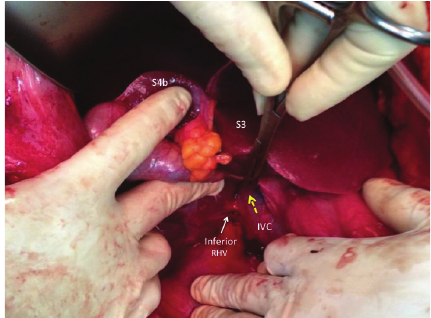
Figure 5: Segments III (S3) and IVb (S4b) of the liver are elevated to allow access to the IVC caudally. This allows access to the avascular plane on the IVC surface. A large vascular clamp bluntly dissects the avascular space in a cephalad direction as indicated by the broken yellow arrow. An inferior right hepatic vein has been identified and preserved.